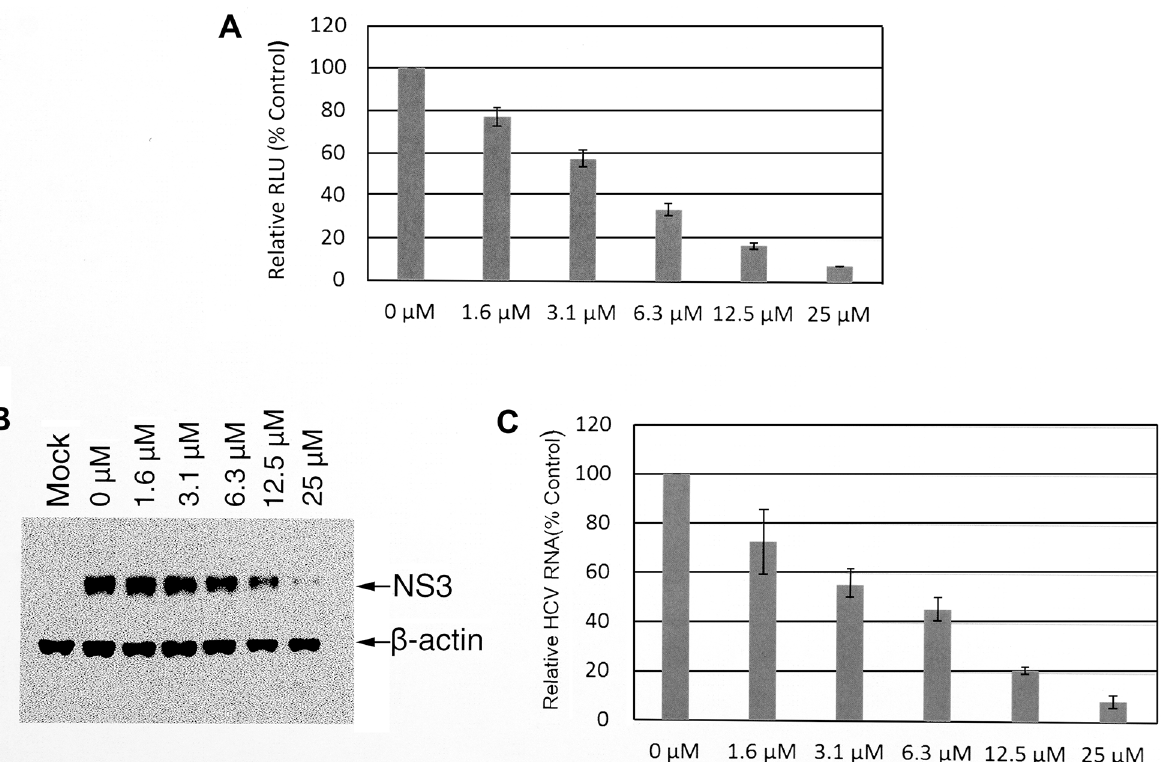
Fig 2. Tannic acid inhibits HCV infection. (A) The effect of tannic acid on an infectious HCV cell culture system. Huh7.5 cells in 96 well plates were infected with HCV JFH1-AM120-Rluc for two hours in the presence of the specified concentrations of tannic acid, cells were washed with PBS and incubated for 48 hours. Cells were lysed and luciferase activity was measured as described in Materials and Methods. The results for three experiments are shown as mean RLUs ± SD of triplicate cell culture assays in 96-well plates. The IC 50 was 5.8 ± 0.38 μ M. (B) The effect of tannic acid on the production of HCV NS3 protein. Huh7.5 cells were infected with JFH1-AM120-Rluc for two hours in the presence of the specified concentrations of tannic acid, cells were washed with PBS and incubated for 48 hours. Cells were lysed and Western blotting was done with anti-HCV NS3 antibodies as described in Materials and Methods. The image represents three different experiments. (C) The effect of tannic acid on the production of HCV RNA. Huh7.5 cells were infected with JFH1-AM120-Rluc for two hours in the presence of the specified concentrations of tannic acid, cells were washed with PBS and incubated for 48 hours. The total RNA was extracted and qPCR assays for HCV RNA were done as described in Materials and Methods. Error bars represent the mean ± SD of results from three